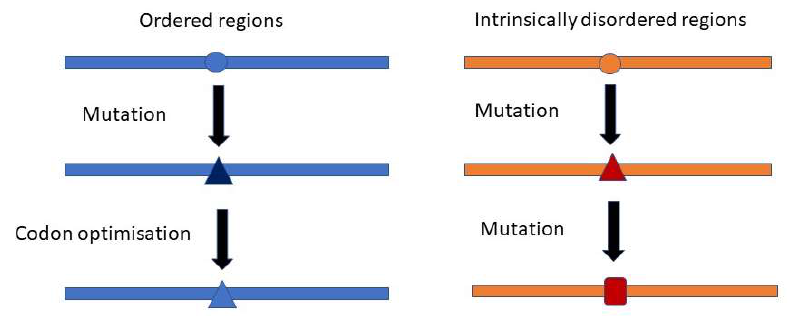
Figure 4. Mutational robustness of IDRs and codon optimization. The low rate of non-synonymous mutations in the ORs allows the optimization of the sequence towards the selection of abundant codons in the host. The high rate of non-synonymous mutations in IDRs prevents this optimization. Due to the presence of less frequent codons in IDRs, the corresponding pools of loaded tRNAs in the host cell are lower than those of abundant codons.